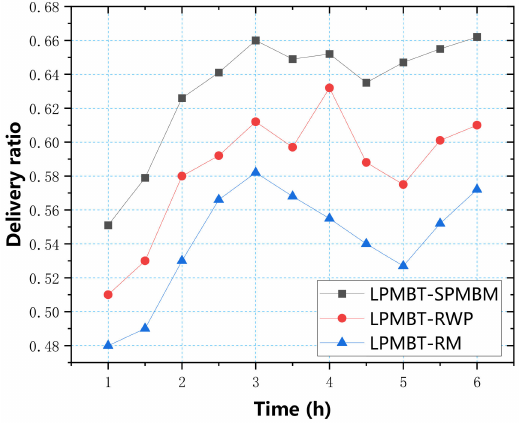
Figure 10. Delivery ratio in three mobile